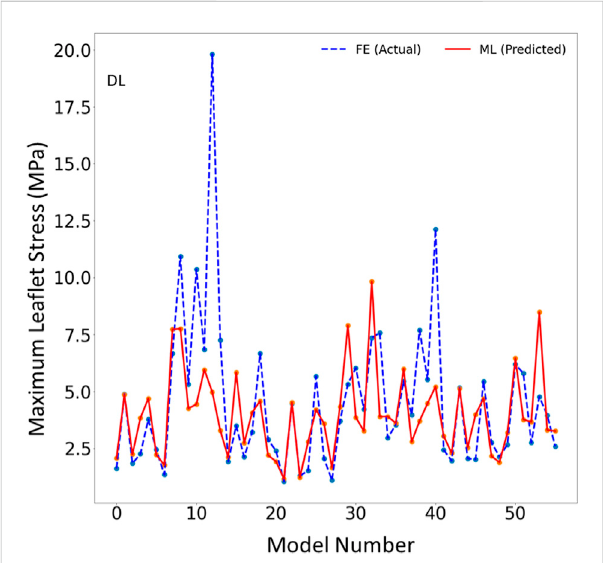
FIGURE 6 The maximum lea fl et von Mises stress for the test set obtained from FE (ground truth) and DL (predicted). Python (3.7, https://www. python.org/) was used to create this fi gure.